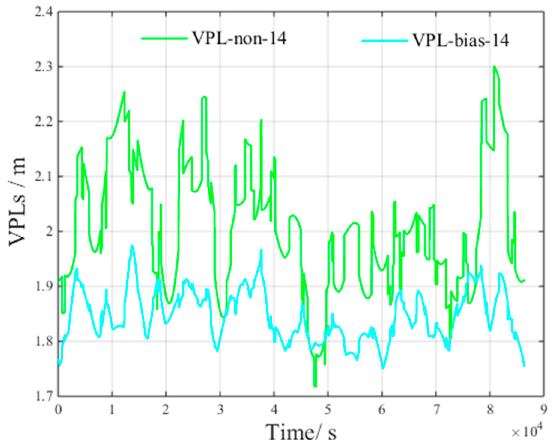
Figure 11. VPL of 14 visible satellites under non-nominal troposphere.